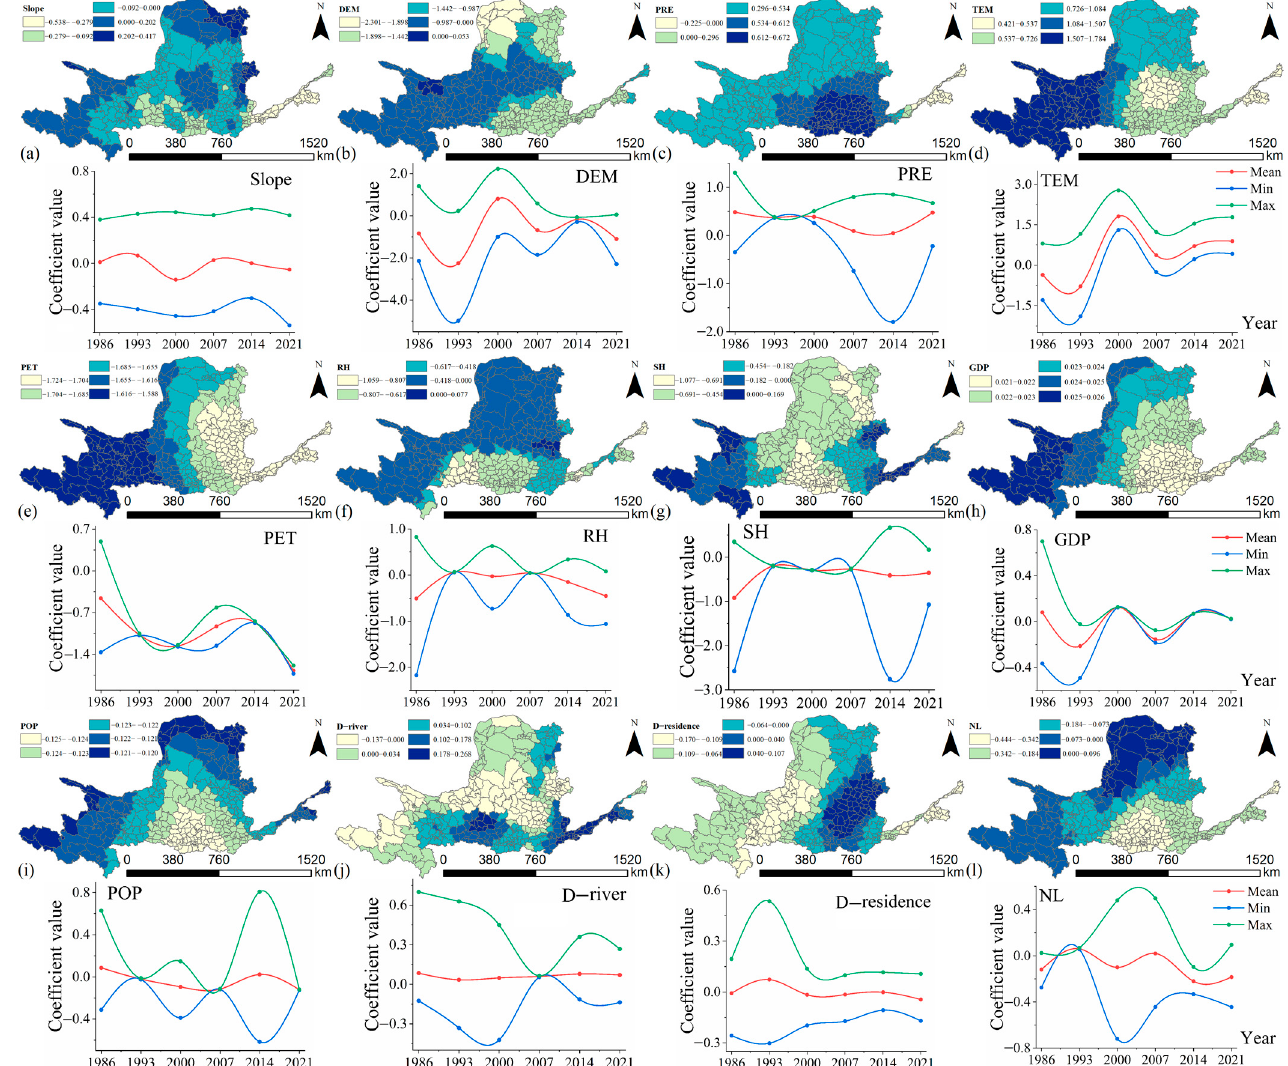
Figure 6. Spatial pattern of regression coefficients between related factors and vegetation: (a) Slope; (b) DEM; (c) PRE; (d) TEM; (e) PET; (f) RH; (g) SH; (h) GDP; (i) POP; (j) D − river; (k) D − resi- dence; (l) NL. Note: The magnitude of regression coefficient indicates the strength of spatial non- stationarity.